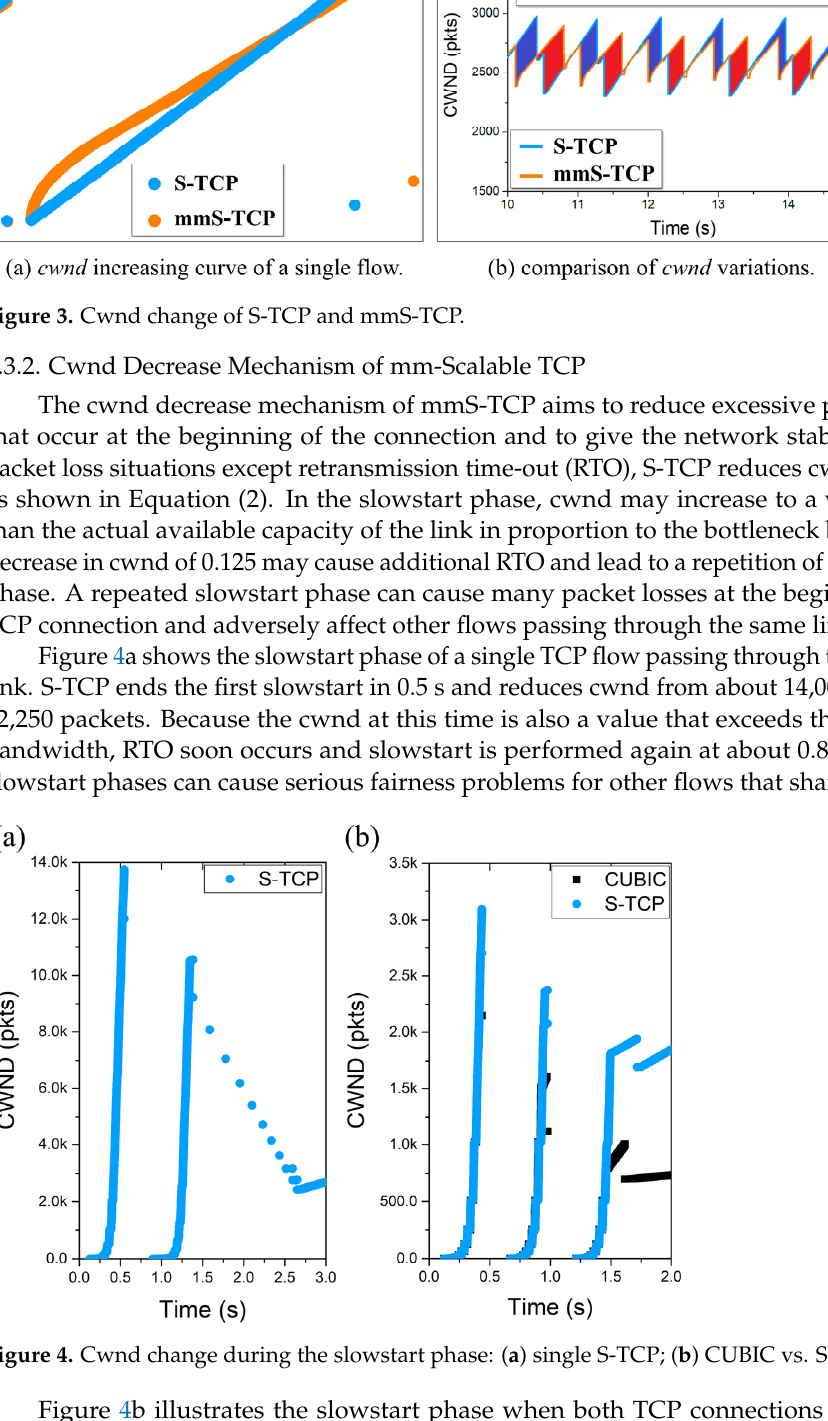
Figure 5. Duplicated ACKs generated during the slowstart phase: ( a ) CUBIC flow; ( b ) S-TCP flow. In a situation where two CUBIC flows compete, approximately 11,000 duplicated ACKs occurred in each CUBIC flow during the slowstart phase. This corresponds to 1.4% and 1.1%, respectively, of the total number of packets. However, when CUBIC flows com- pete with S-TCP, 14,784 duplicated ACKs are generated, representing 2.8% of the total packets. Therefore, in CUBIC, multiple duplicated ACKs are generated by the slowstart repetition induced by S-TCP. Therefore, in order to eliminate unnecessary slowstart repetition and provide stabil- ity to the network, the cwnd decrease mechanism of the S-TCP was changed as follows: 1.